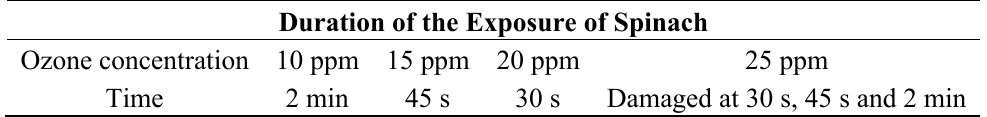
Table 1. The maximum ozone exposure levels that can be applied on spinach without causing visible